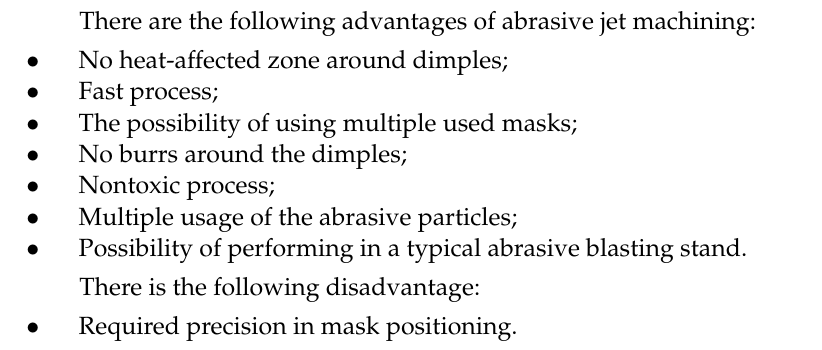
Figure 4. Examples of dimples and patterns made with abrasive jet machining, ( a ) square array, and ( b ) spiral array.